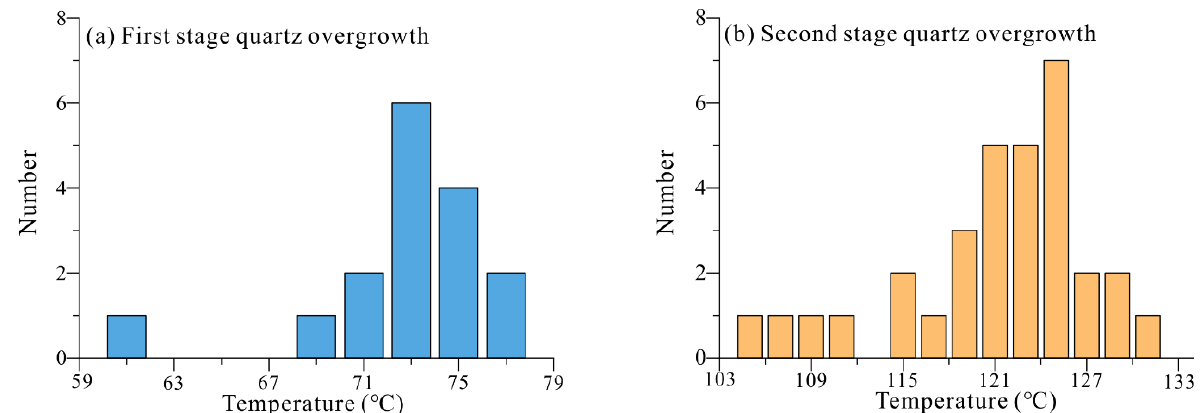
Figure 8. Frequency histogram of homogenization temperature from inclusions in authigenic quartz cements of the Toutunhe Formation sandstone. ( a ) Homogenization temperature of the first stage quartz overgrowth; ( b ) homogenization temperature of the second stage quartz overgrowth.